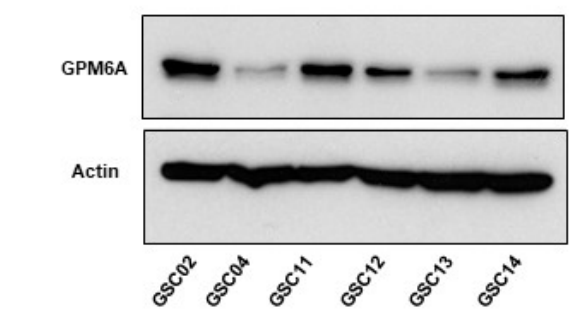
Figure 2. GPM6A is overexpressed in the highly invasive GBSC. mRNA expression of ( A ) GPM6A and ( B ) GPM6B was analyzed by real-time PCR in the 14 primary neurospheres. GAPDH was used for normalization. Results are presented as fold compared to GSC04 expression (which presents the lowest expression). Quantifications between the two groups, highly invasive and low invasive, are presented as means ± SD. ** 0.001 < p < 0.01; NS, non-significant. ( C ) GPM6A protein expression was analyzed by Western blot analysis in a panel of highly invasive and low invasive neurospheres.